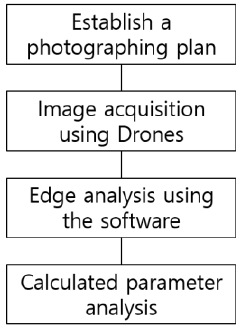
Figure 1. Procedure for image quality analysis